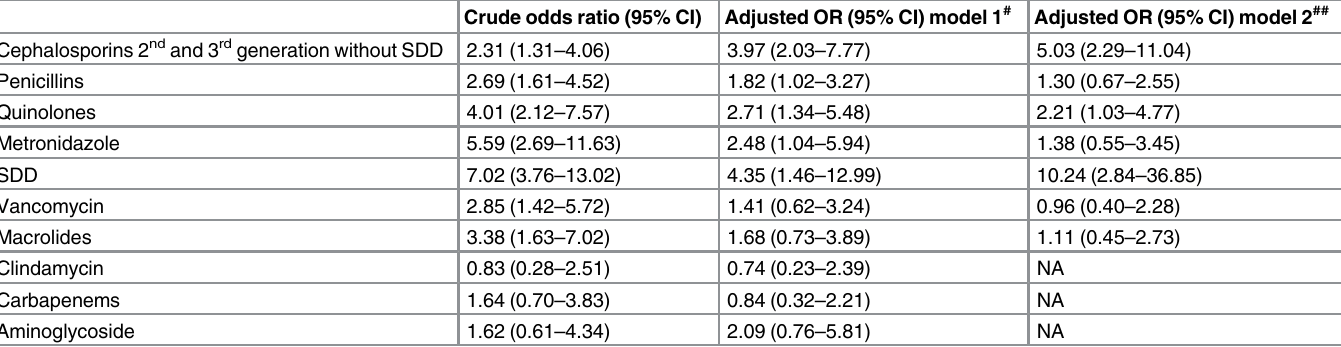
Table 3. Crude and adjusted odds ratios of antibiotic classes as a risk factor for CDI ribotype 027 compared to non-CDI control